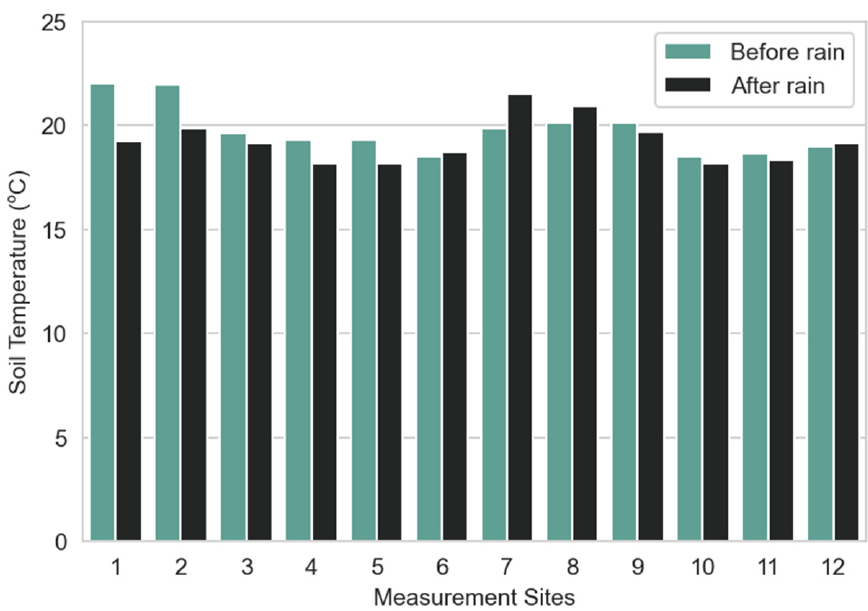
Figure 15. Average soil temperatures per measurement site before and after rain.